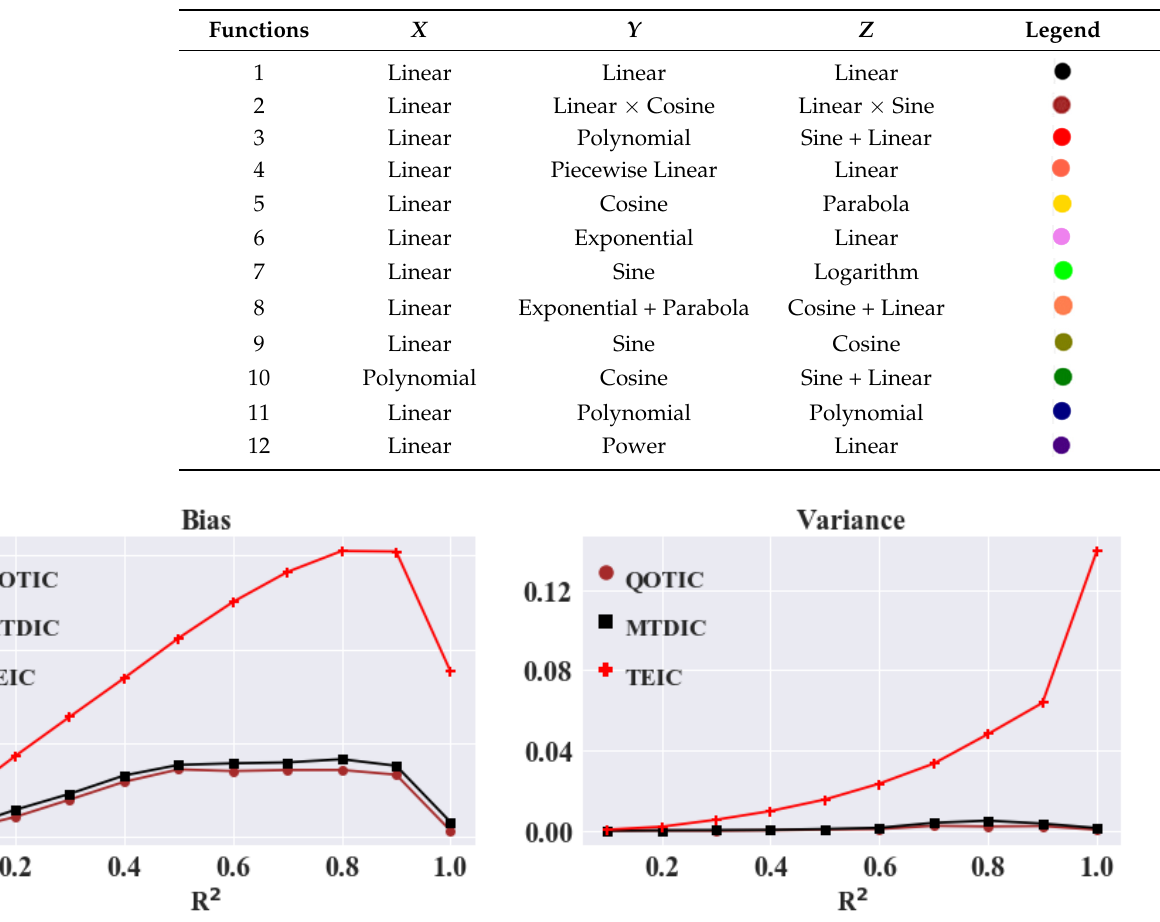
Figure 4. Comparison of bias and variance of QOTIC, MTDIC, TEIC. Table 1. The color on a relationship and the variable on an axis in Figure 3.